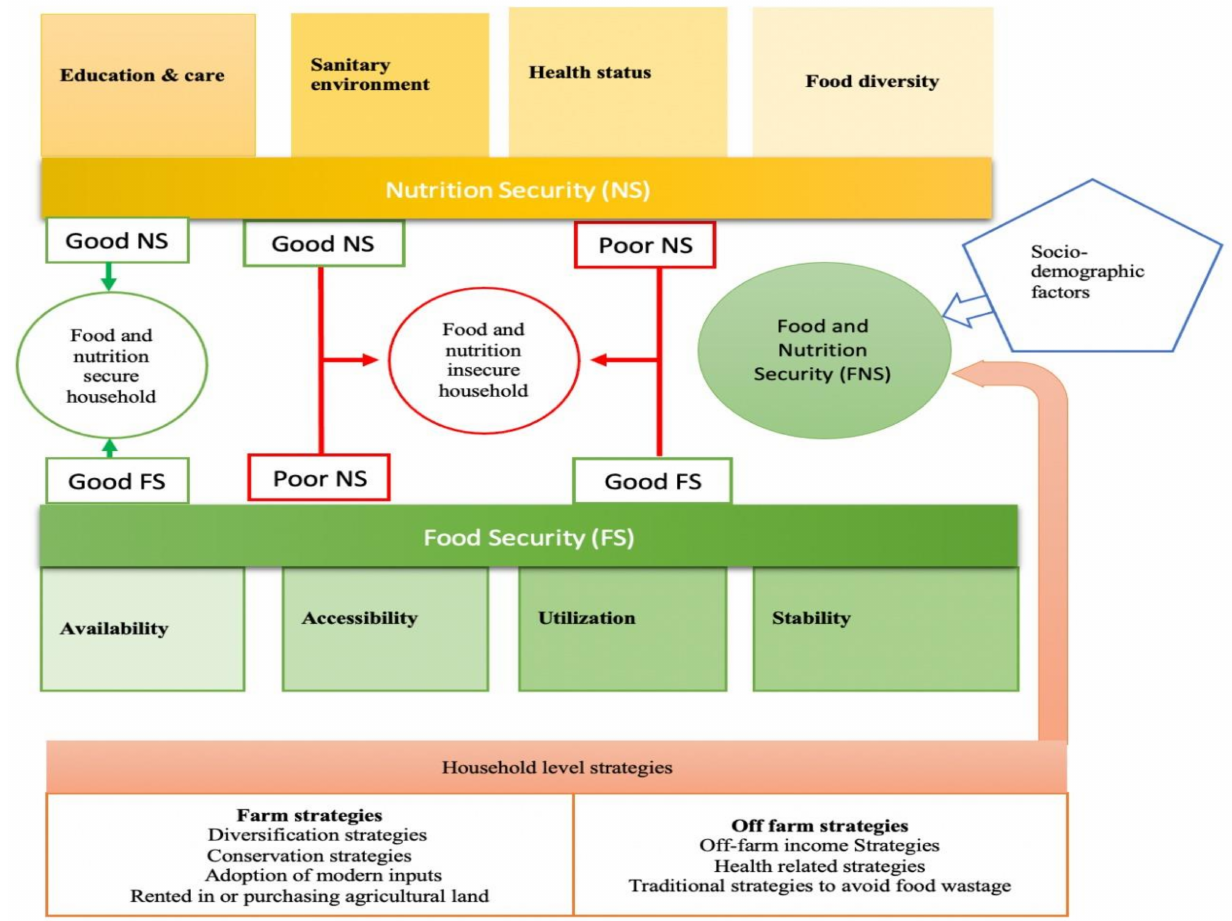
Figure 2. Conceptual framework for FNS of rural